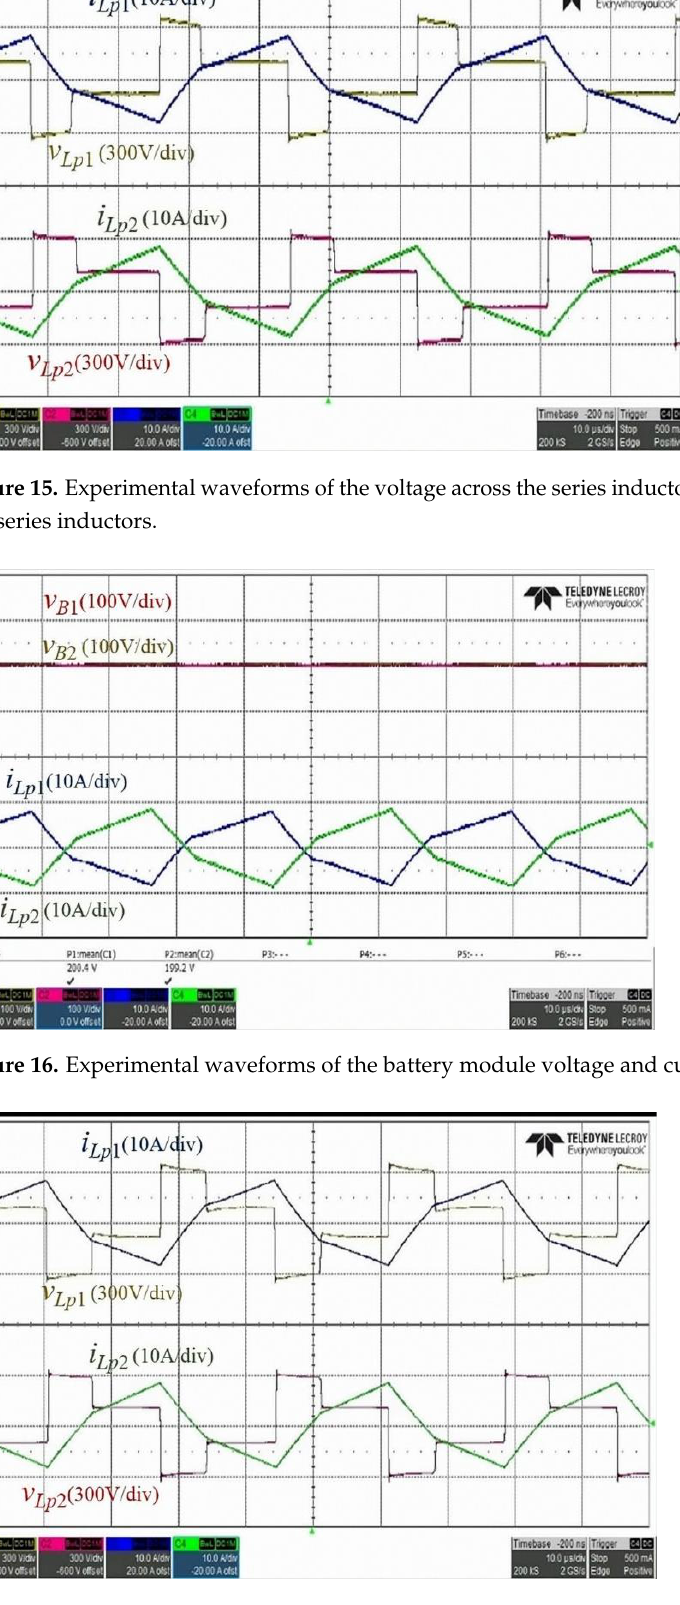
Figure 17. Experimental waveforms of the voltage across the series inductors and the current through the series inductors under unbalanced battery module condition.